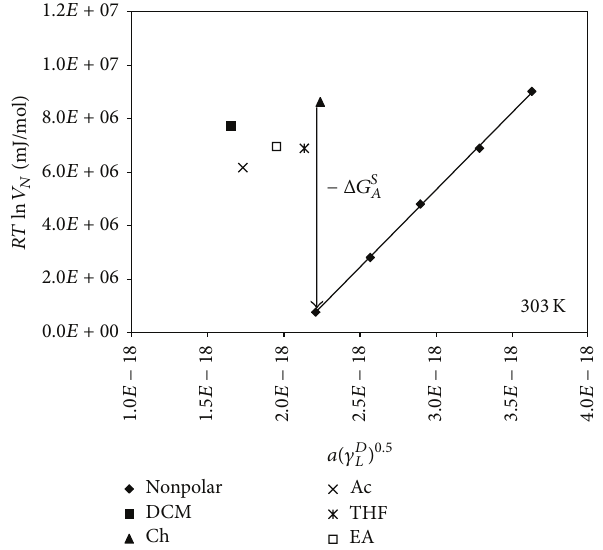
Figure 5: A plot of 𝑅𝑇 ln 𝑉 𝑁 versus 𝑎(𝛾 𝐷 𝐿 ) 0.5 for nonpolar and polar probes on PEG at 303 K.